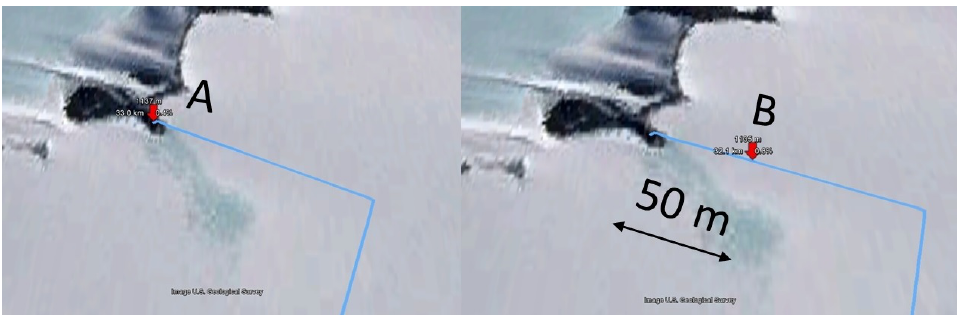
Figure 10. Locations A and B, where the vehicle stopped for a longer period of time.